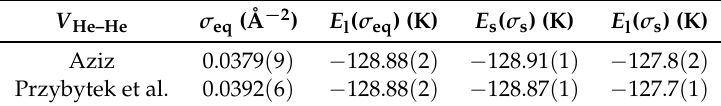
Figure 3. Phase diagram of 4 He adsorbed on graphene. Energies E per particle / N 4 / N ) as a function of (surface) density σ are shown for the two He–He potentials under